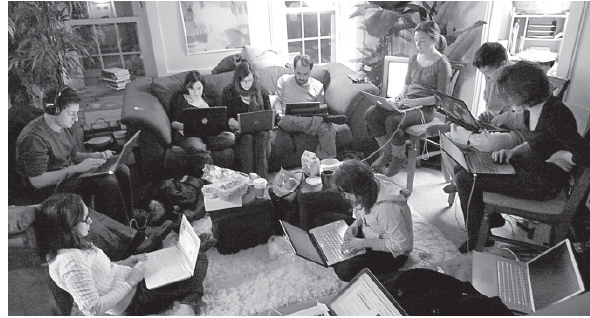
Figure 15: Organised VGI at work - Patrick Meier’s living room – the Ushahidi-Haiti nerve centre at the start of the crisis.